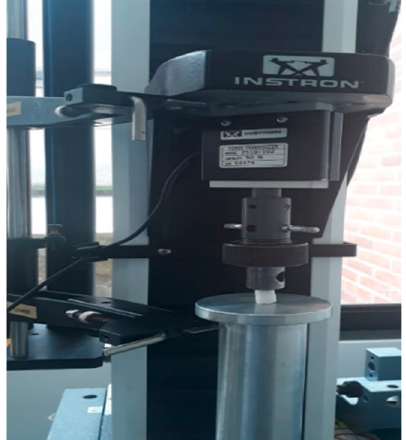
Figure 3. Assembly illustration for mechanical